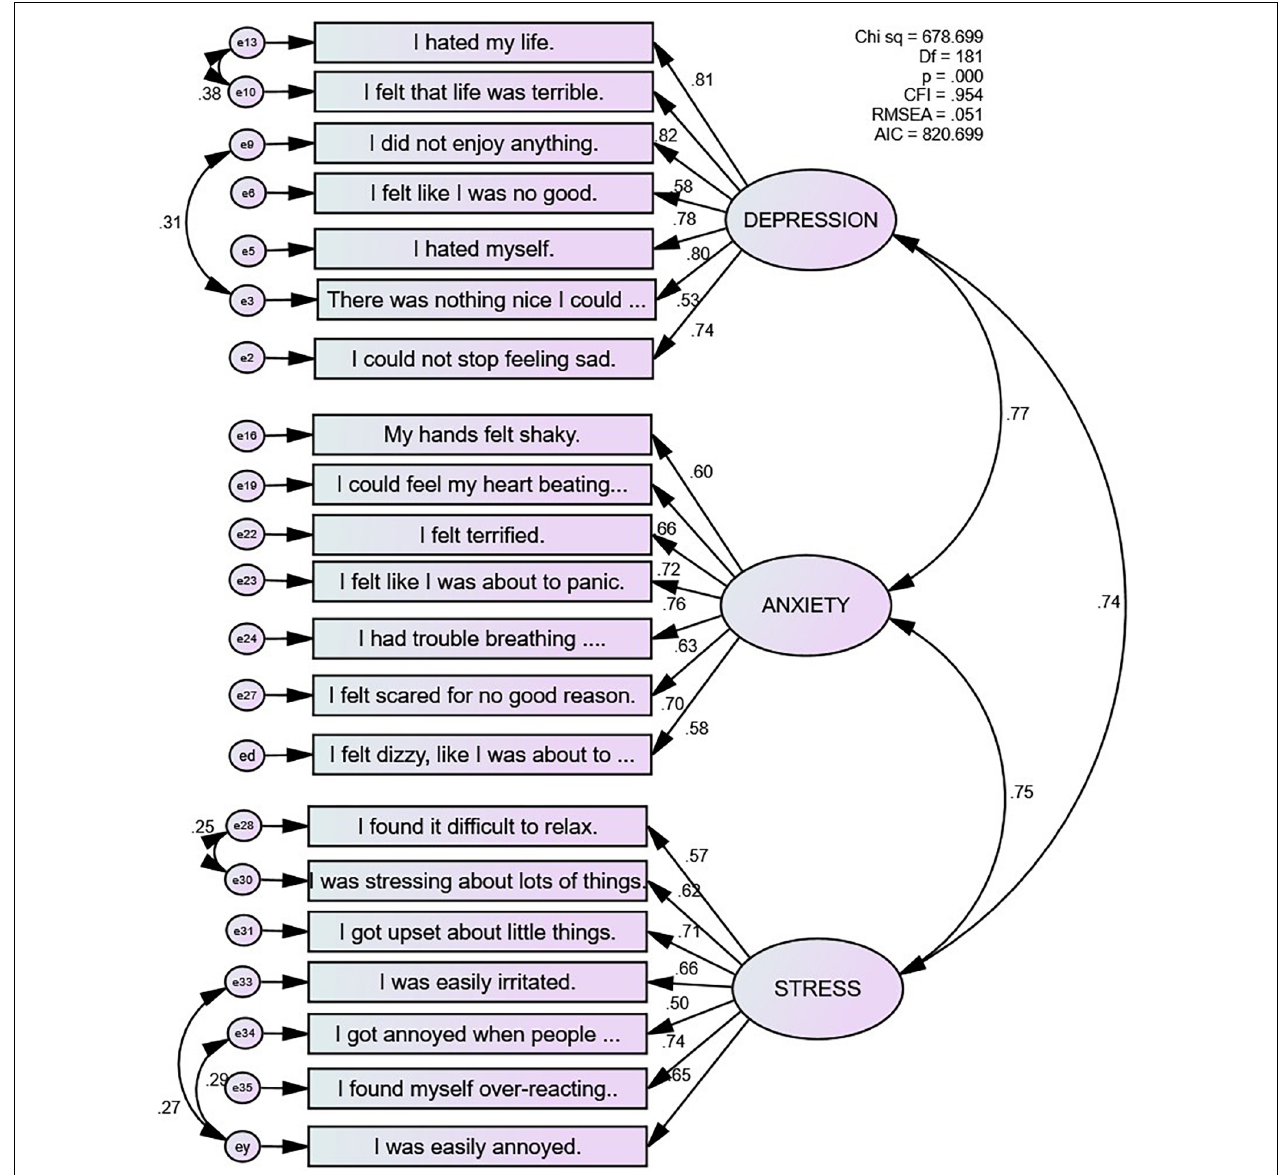
FIGURE 1 | The 21-item DASS-Y model in the calibration sample ( N = 1075).